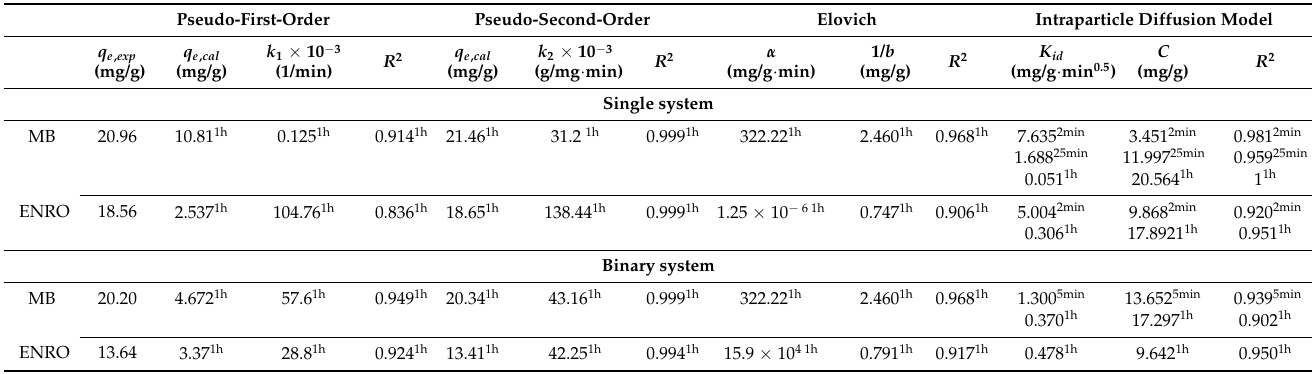
Table 2. Kinetic parameters for the adsorption of MB and ENRO onto HNC for single and binary